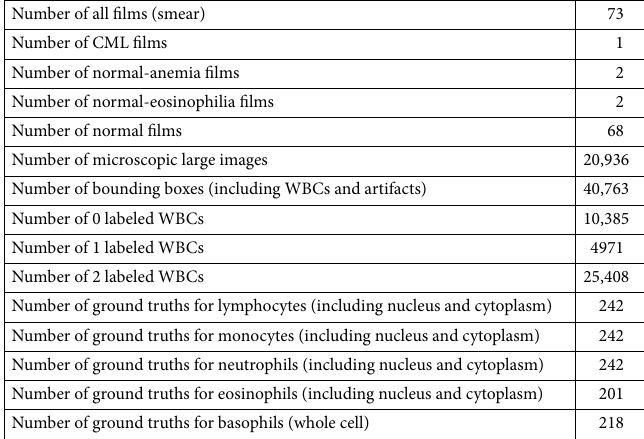
Table 3. Raabin-WBC information table.